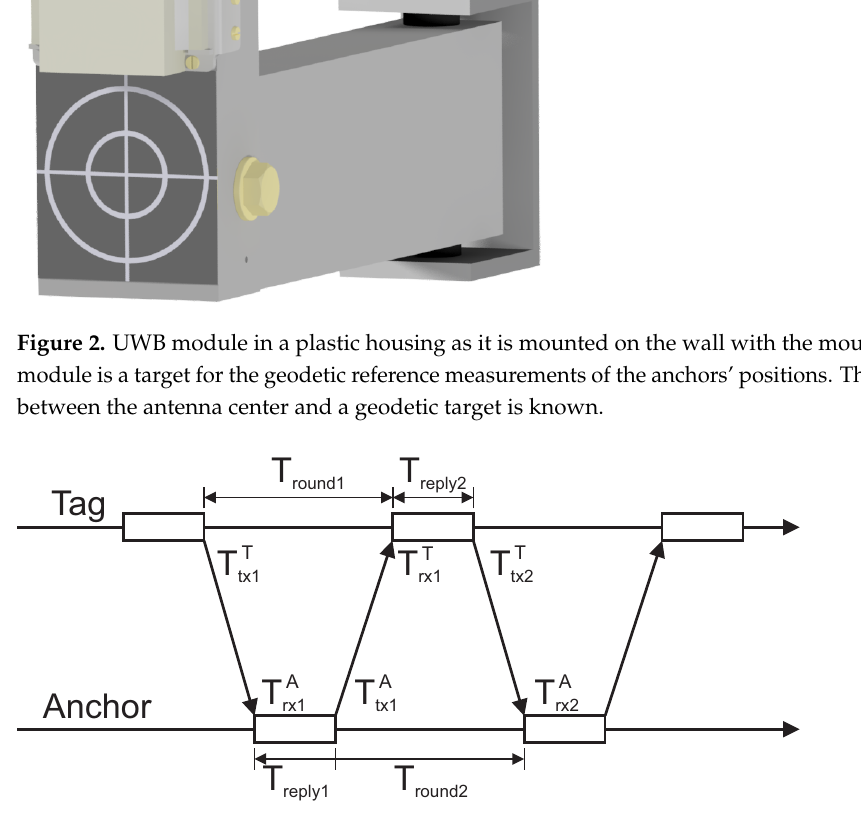
Figure 3. Double-sided two-way ranging with four messages. In this way, all the timestamps for the time-of-flight calculations are collected on the tag